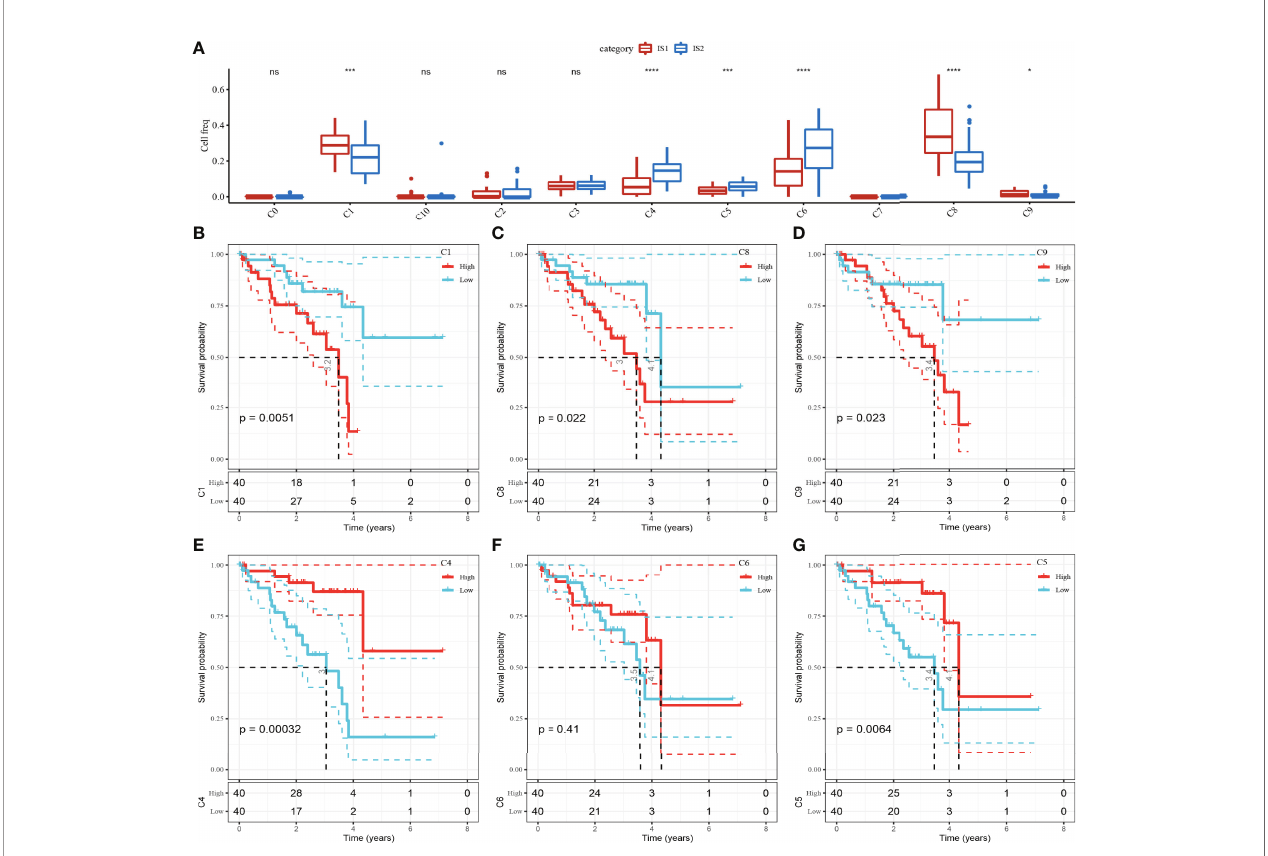
FIGURE 5 | The abundance of 11 kinds of cell clusters in different ISs and their effects on the prognosis of UM. (A) The 11 cell subpopulations score differences between the two ISs. (B – G) Kaplan – Meier survival plots of UM patients grouped by C1, C4, C5, C6, C8, and C9 clusters. ns, no signi fi cance. * p < 0.05, *** p < 0.001, **** p <